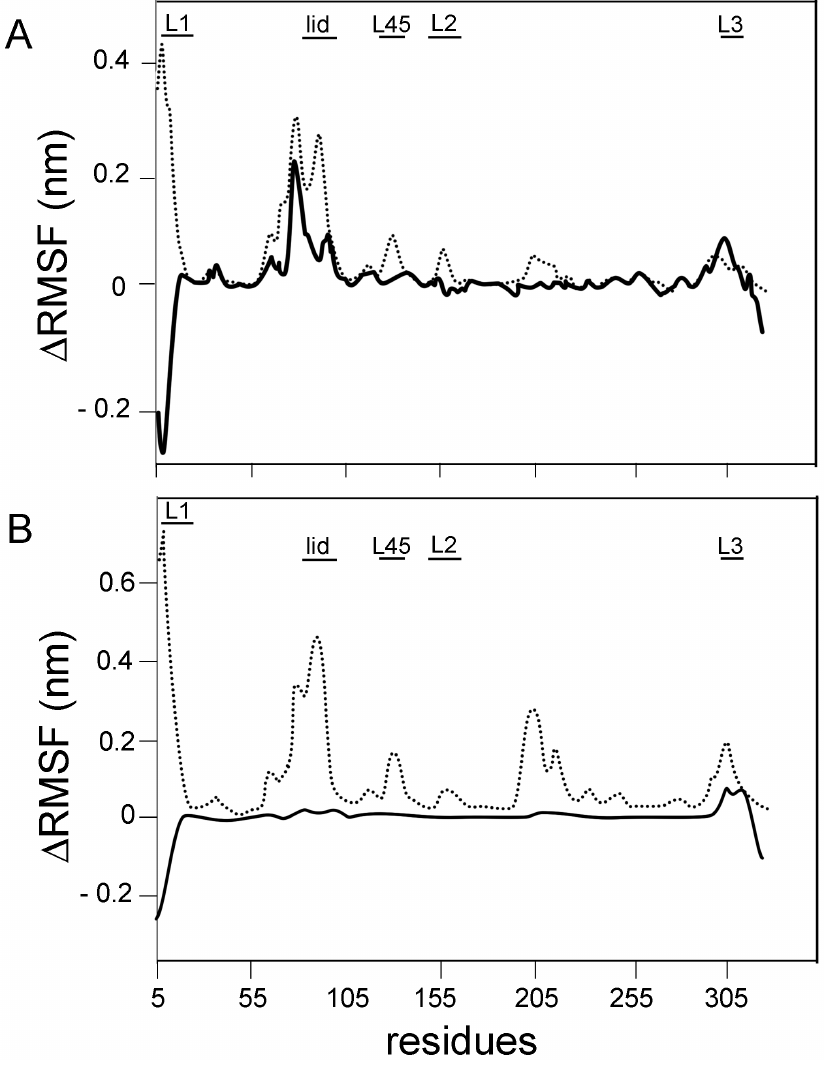
Figure 4. Analysis of PaNTD and EcNTD monomers residues mobility using structure based models (SBM). Root Mean Squeare Fluctuation (RMSF) difference between A) apo and ATP-bound monomer and B) ADP and ATP-bound monomer, for EcNTD (dotted line) and PaNTD (full black line) were calculated from SBM MD simulations. Dimerization interface (L1, L2, L3, L45 and ATP lid) is indicated with black horizontal bars.